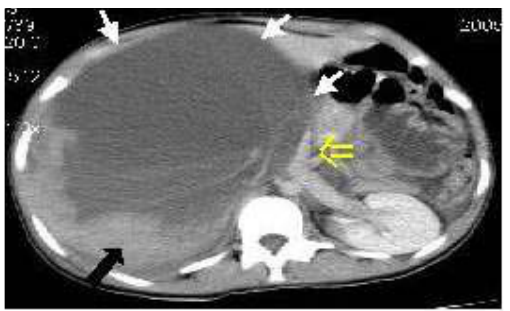
FIGURE 1. Contrast-enhanced CT revealing a very large right retroperitoneal mass with higher density representing large hematoma with fresh hemorrhage (black arrow) and organizing hematoma (white arrows). Mass displacing the right kidney and IVC to the left side (open arrow).